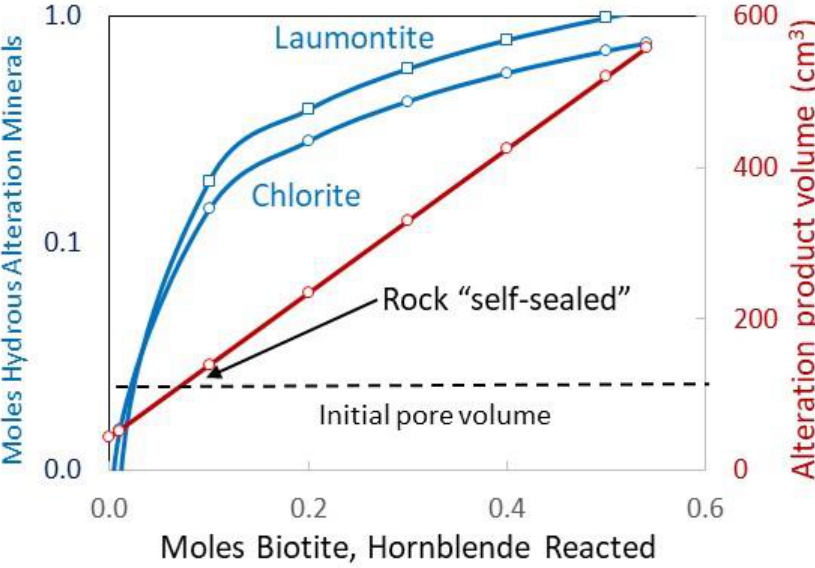
Figure 2. Rock volume trends at 100 ◦ C. Points are model-calculated